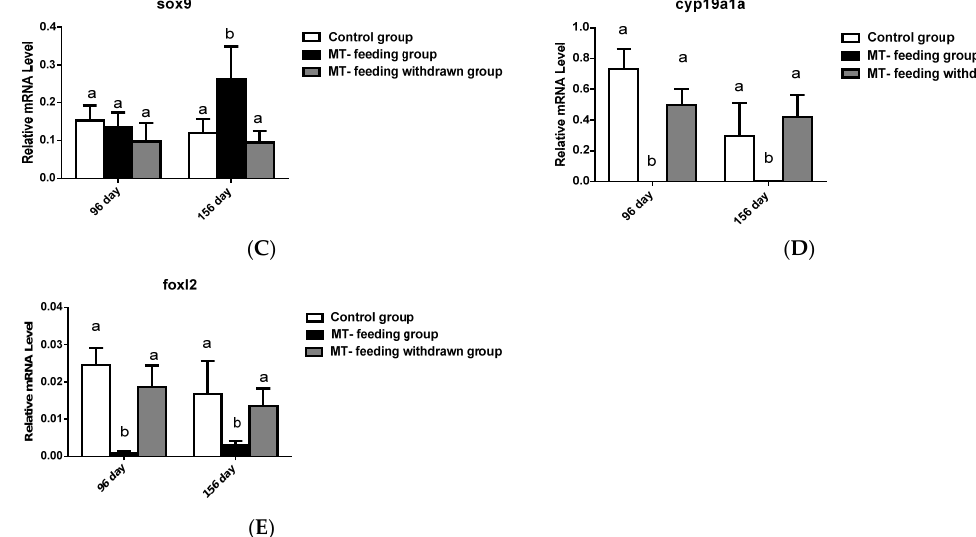
Figure 7. Expression profiles of key genes known to be involved in sex differentiation after MT-feeding withdrawal. ( A – C ) showed the expression of male-related genes dmrt1 , sox9 , and cyp11b at the 60th day after MT feeding withdrawal, respectively. ( D , E ) showed the expression of female-related genes cyp19a1a and foxl2 at the 60th day after MT feeding withdrawal. β -actin was used as the internal control. Data are expressed as the mean ± SD for three replicates obtained from five different fish. Different letters indicate significant values at p < 0.05.